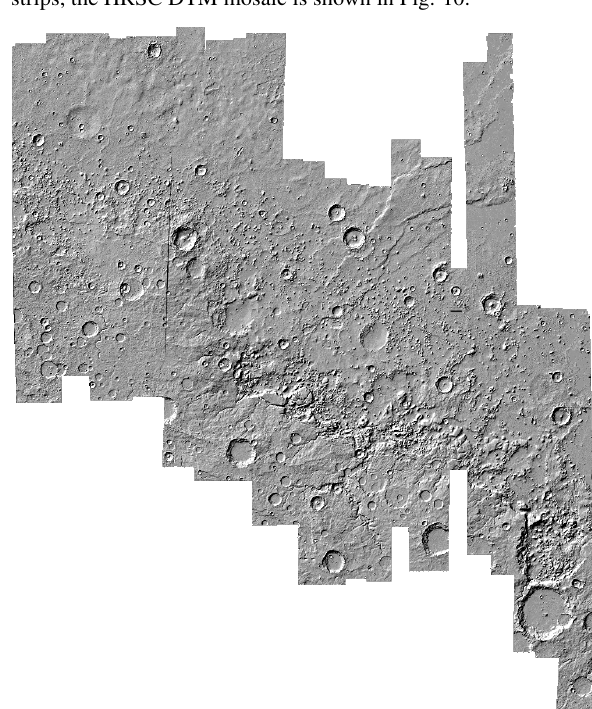
Figure 10: Shaded relief of a HRSC DTM mosaic generated with the block adjusted orientation